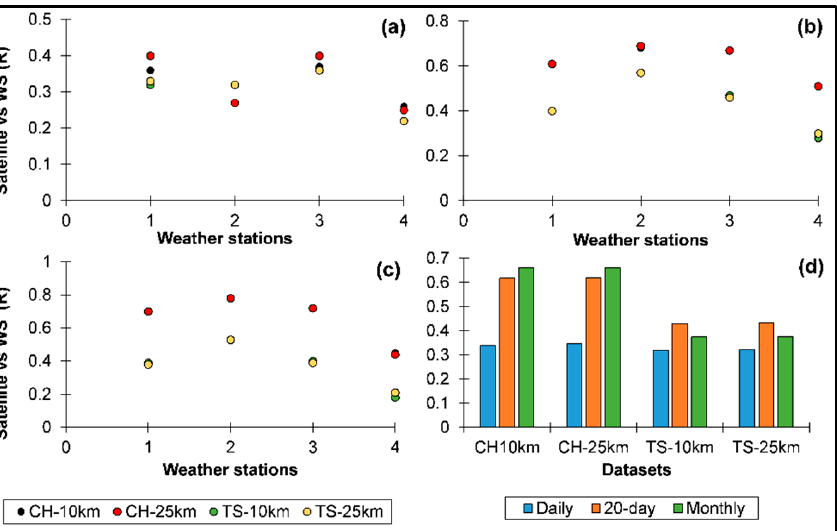
Figure 3. Correlations of WS and satellite data at ( a ) daily, ( b ) 20-day, and ( c ) monthly intervals. ( d ) Mean correlations between WS and satellite data.